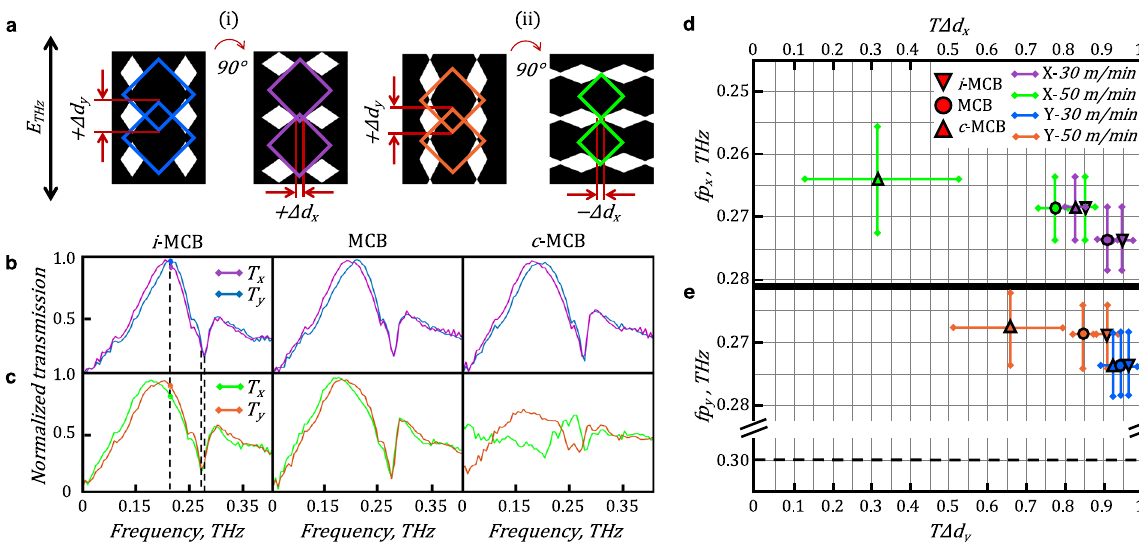
Fig. 2 1D terahertz spectroscopy characterization. a Principle of electromagnetic fi eld interactions with the samples in X- and Y- directions: (i) i- MCB antisymmetric pattern for X- and Y- directions; (ii) i- MCB and c- MCB behavior for Y- and X- directions, respectively. Normalized transmission of printed i -MCB, MCB, and c- MCB sample with b 30 and c 50 m/min. d , e Extracted values of lattices and laps/gaps from THz-TDS measurements for X- and Y- directions, respectively. The horizontal and vertical lines show the standard deviation obtained from measuring normalized transmission at 0.22 THz ( T Δ d ) and the frequency minima ( fp ) of fi ve replicas for each